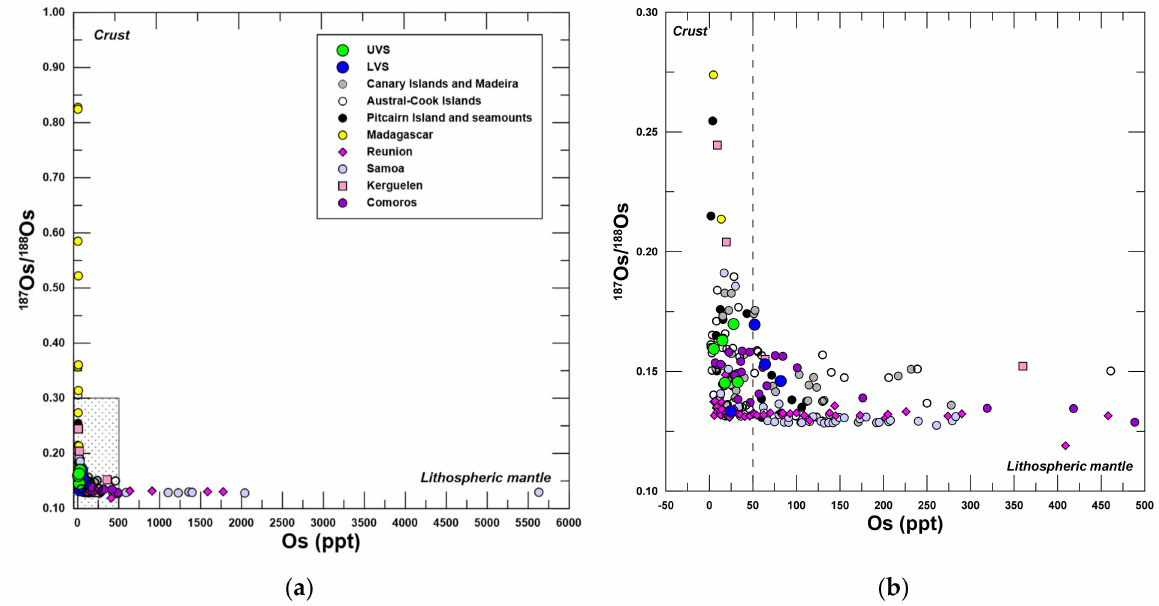
Figure 13. ( a ) 187 Os/ 188 Os versus Os (ppt) for the Christmas Island lava series compared to other intraplate lava suites, shaded rectangle is the area shown in ( b ). Symbols and data sources as for the legend to Figure 12 with the additional data and suites (see legend in ( a )) as follows: Canary Islands and Madeira [79]; Pitcairn [91]; Austral-Cook [89,95]. The vertical dotted line in b) at Os 50 ppt is the proposed cut-off filter of [79] to eliminate crustally contaminated lavas. Typical lithospheric mantle 187 Os/ 188 Os values vary between 0.105–0.135 and Os (ppt) values vary from 500–5000